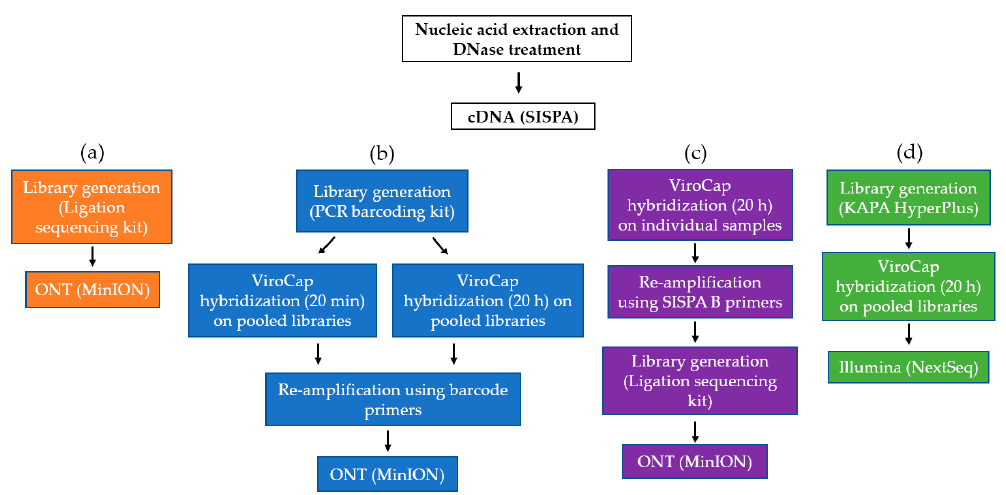
Figure 1. Workflow of the laboratory procedures evaluated in this study. ( a ) Shotgun approach for a baseline on Oxford Nanopore Technologies (ONT) platforms; ( b ) ViroCap on pooled barcoded library pools using a 20 min and 20 h hybridization time; ( c ) ViroCap on individual samples using a 20 h hybridization time; ( d ) standard ViroCap protocol on Illumina platforms. Abbreviations: ONT, Oxford Nanopore Technologies; SISPA, Sequence-Independent Single-Primer-Amplification.